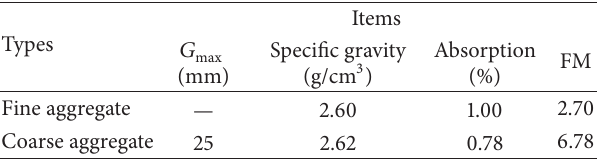
Table 2: Physical properties of fine and coarse